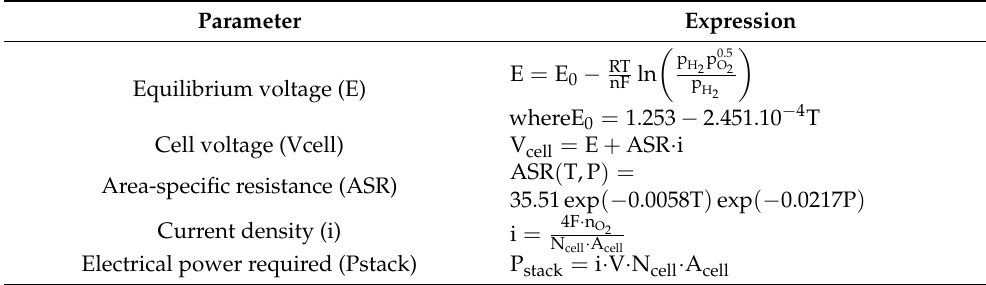
Table 5. Summary of mathematical equations coded in the CALC block of Aspen Plus.